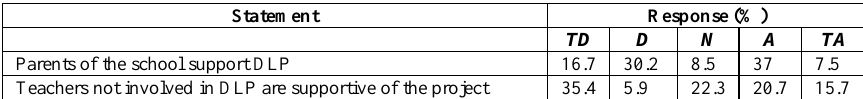
Table 4. Teachers responses on environmental readiness